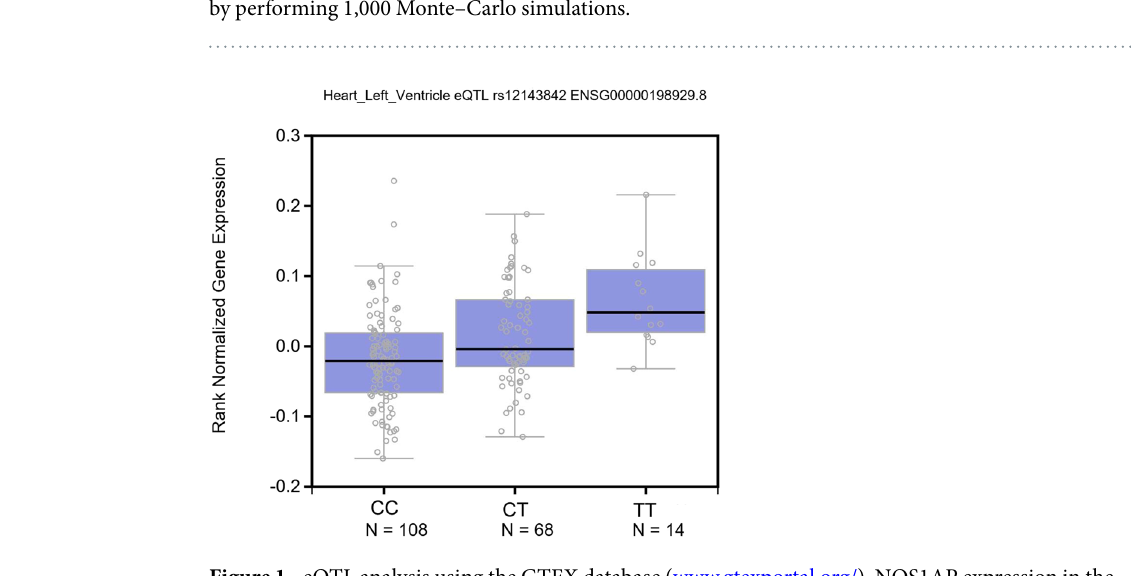
Table 3. Genotypic association of rs12143842 with IVT. # Adjusted by age, sex. $ Empirical P values were derived by performing 1,000 Monte–Carlo simulations.